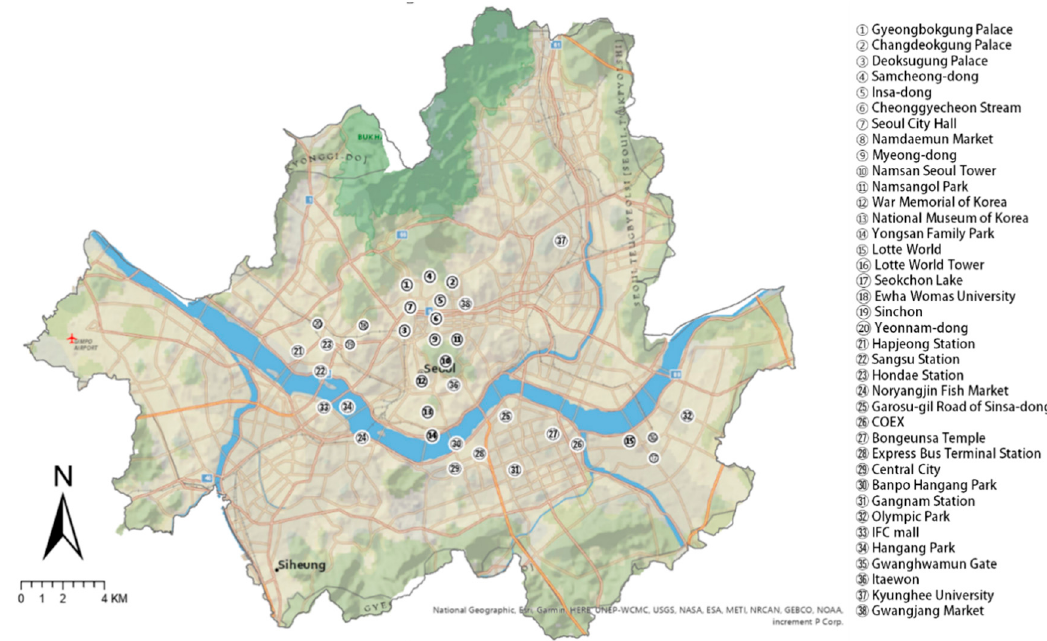
Figure 9. Major tour attractions in Seoul.